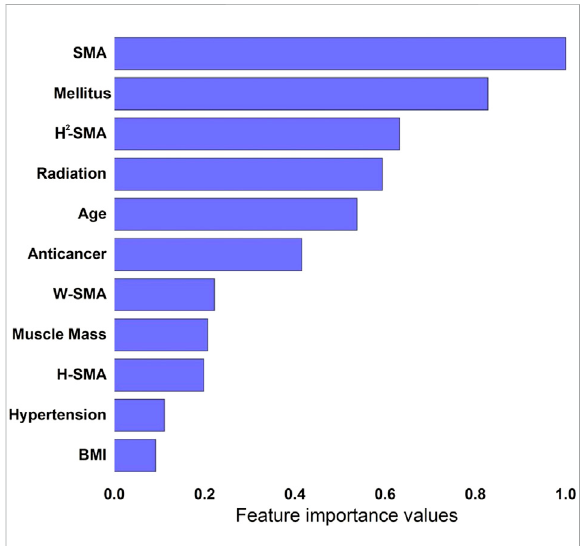
FIGURE 2 Results of feature importance analysis from XGBoost: SMA is with the highest importance value, followed by diabetes mellitus, H 2 -SMA, radiation therapy, age, anticancer chemotherapy, W-SMA, muscle mass, H-SMA, hypertension, and BMI.